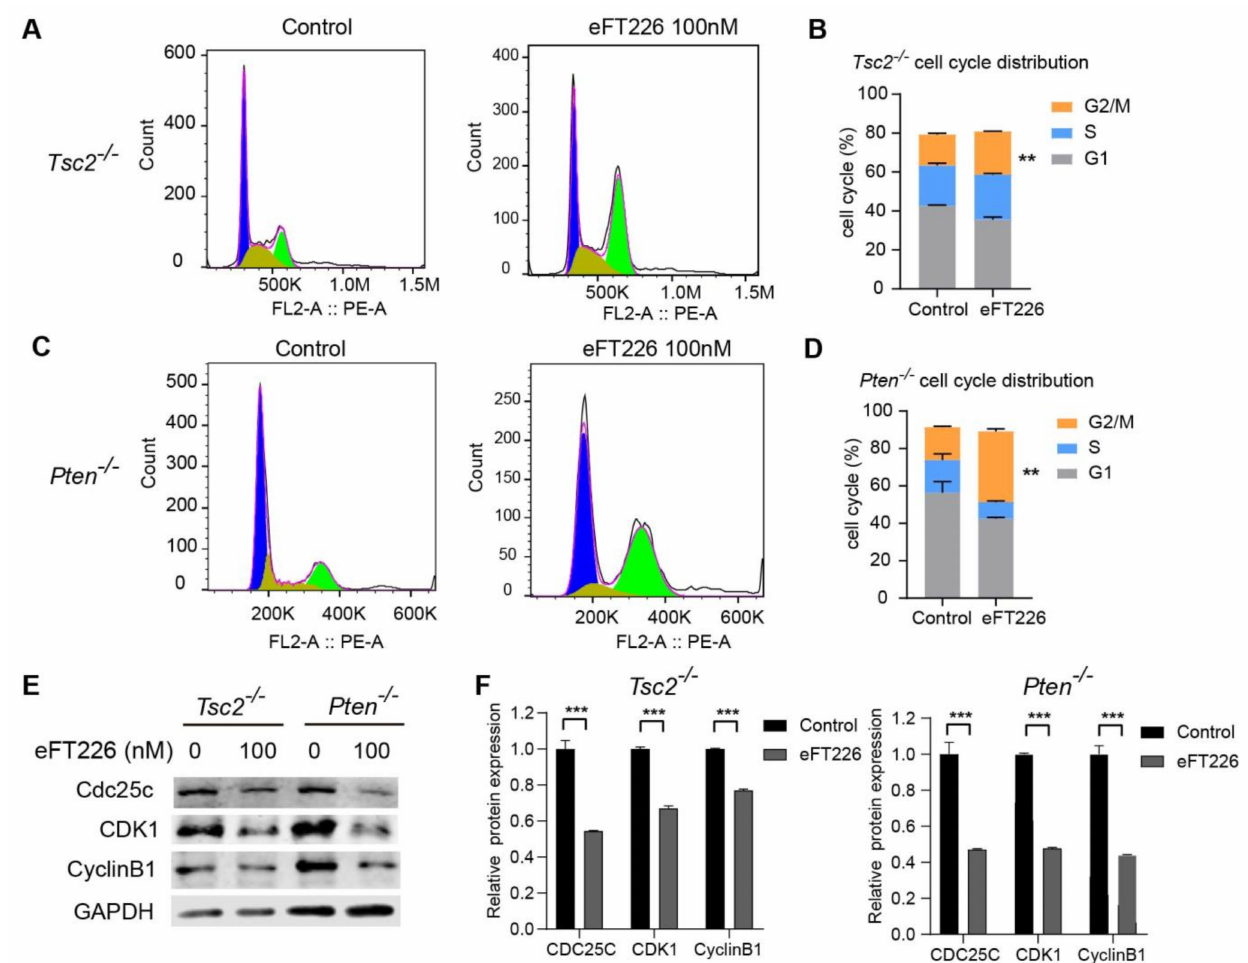
Figure 6. eFT226 induces G2/M arrest in Tsc2 - and Pten -deficient cells. Tsc2 - ( A , B ) and Pten -deficient MEFs ( C , D ) were treated with eFT226 (0 nM, 100 nM) for 48 h in triplicate and cell cycle distribution was measured by PI staining followed by flow cytometry. The populations in G1, S and G2/M stages are shown in blue, yellow and green, respectively. ( E ) Tsc2 - and Pten -deficient MEFs treatment with eFT226 (100 nM) for 48 h were immunoblotted with anti-Cdc25c, anti-CDK1, anti-cyclinB1 antibodies. ( F ) Densitometric quantification of representative immunoblots from E. Values are mean ± S.D. of